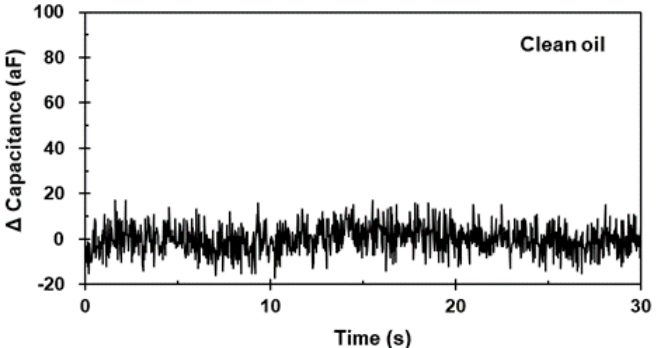
Figure 8. Measured capacitance signals for clean oil conditions.